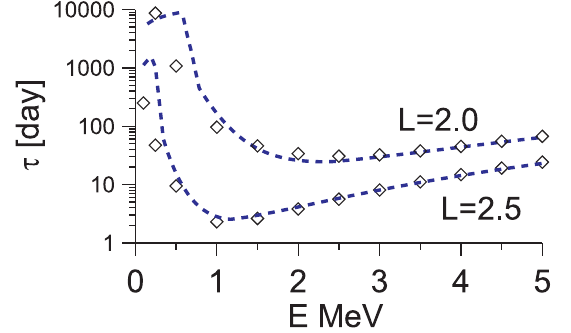
Fig. 20. Analytical lifetimes at L = 2 and 2 . 5 given by Eq. (9) (dashed blue curve) are compared with those obtained by the numer- ical scheme: black diamonds show results obtained with a realistic θ distribution and | n | ≤ 25 ( N r < 10). Electron energy varies be- tween 100keV and 5MeV. Hiss and lightning-generated whistlers are considered.